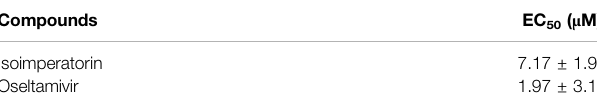
TABLE 3 | Inhibition effects of compounds on